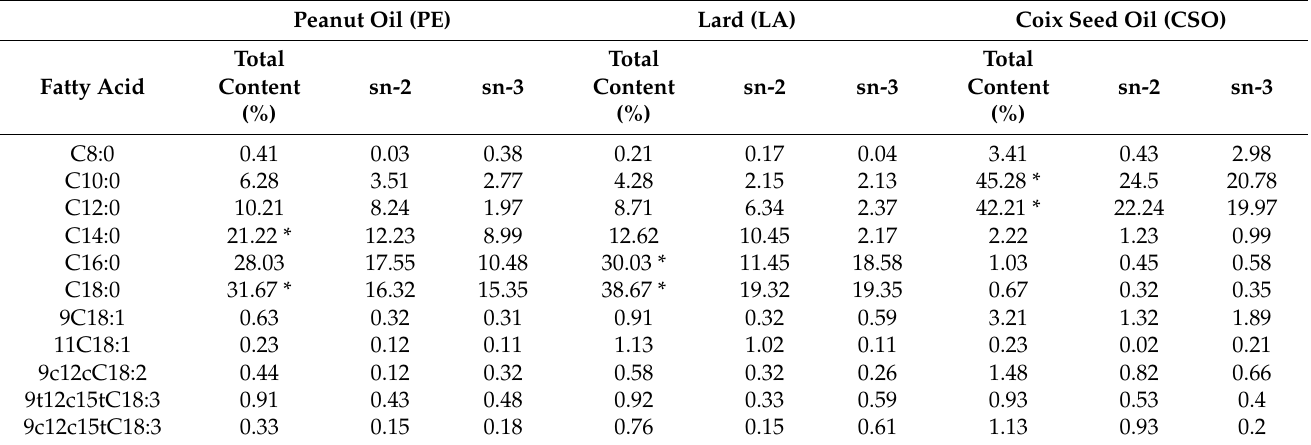
Table 1. Component and distribution of fatty acids in CSO